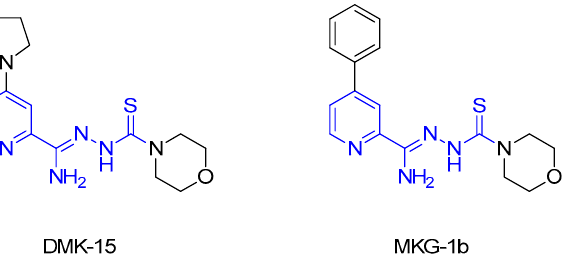
Figure 1. Structures of 2,4-disubstituted thiosemicarbazone derivatives of pyridine DMK-15 and MKG-1b.